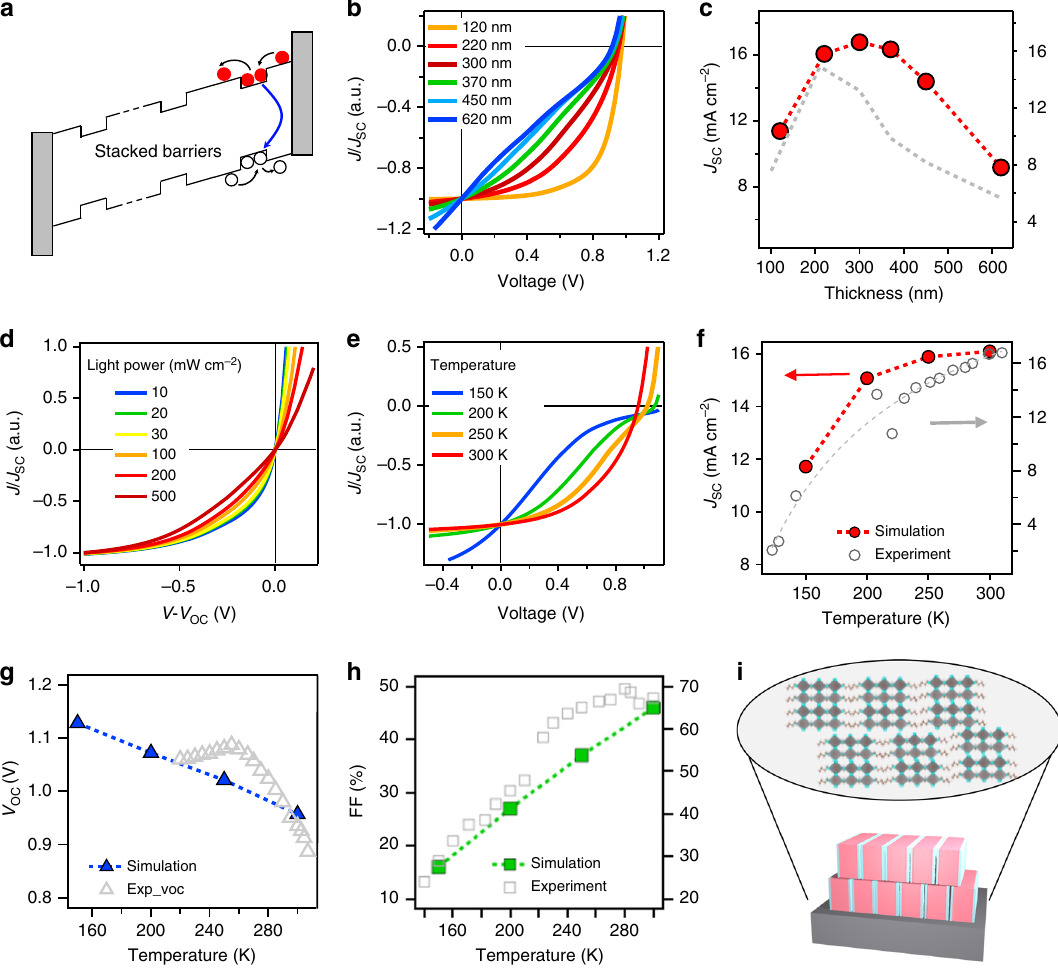
Fig. 5 Model and simulation results. a The model shows potential wells that can prevent carriers from escaping. b , c The thickness dependence of J – V curves and J SC . Very thick structures increase the recombination in wells and reduce e – h Temperature dependence of J – V curves and the extracted J SC , V OC , and FF as a function of temperature. The experimental data taken from Figs. 2 and 4 in gray symbols are plotted along with the simulated data to directly compare the two. i , schematic illustration of vertically packed quantum wells with misalignment in molecular